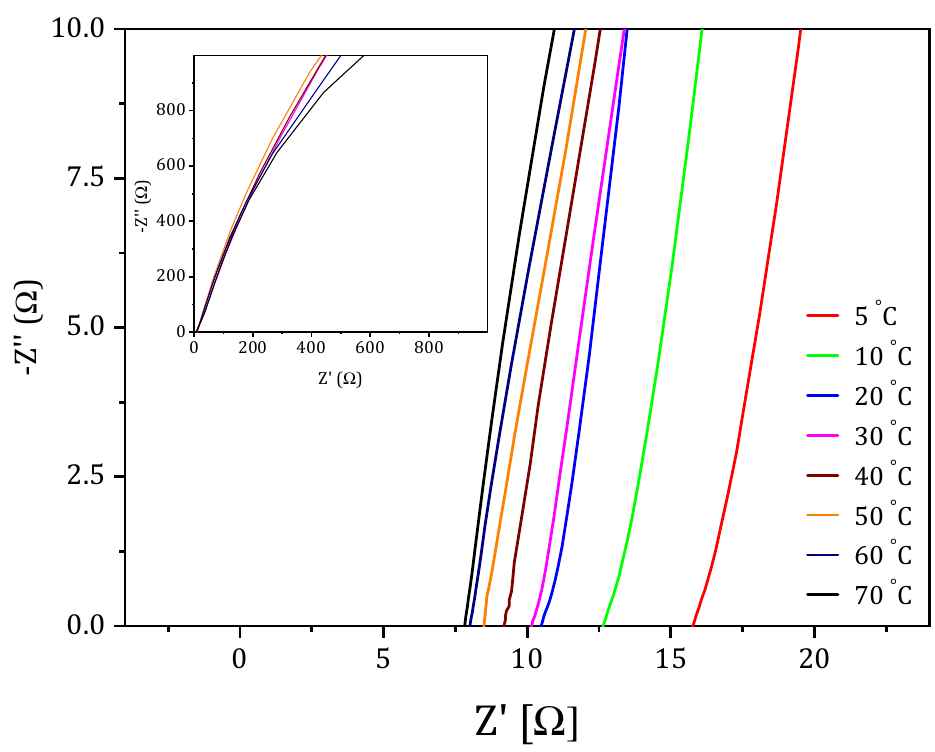
Figure 12. Nyquist plots obtained to calculate the bulk resistance values of the PVA-T4 KOH membrane at different temperatures.